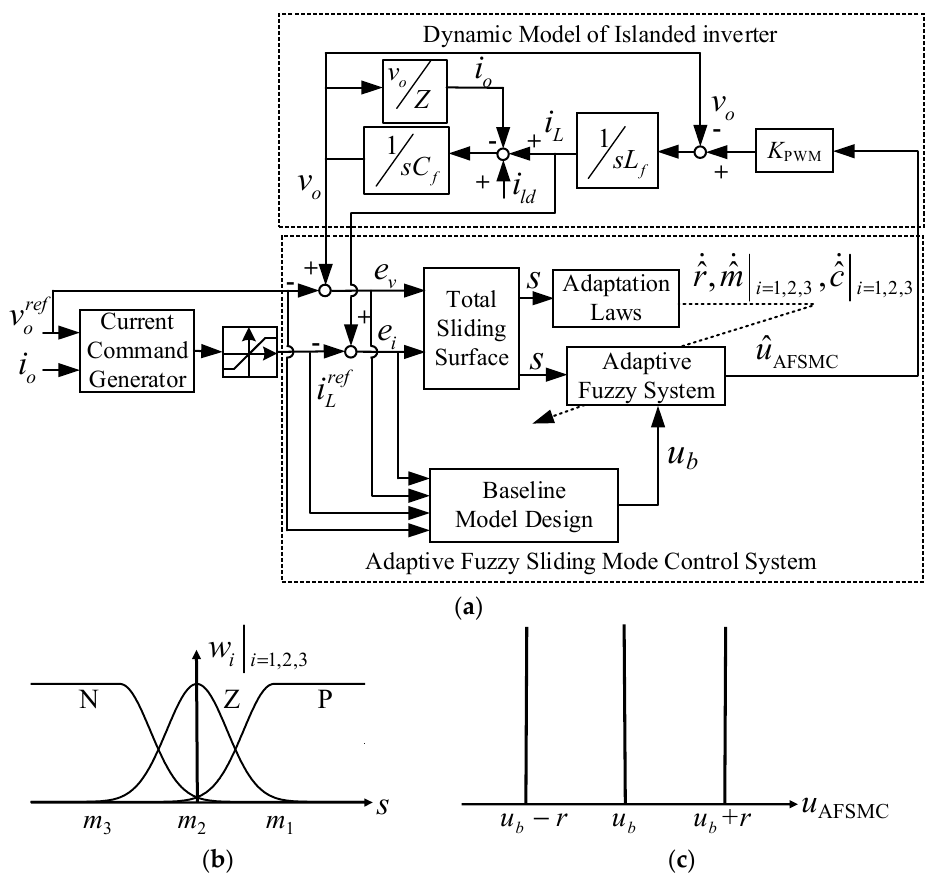
Figure 3. Proposed AFSMC system for islanded inverter: ( a ) Framework; ( b ) Membership function for input fuzzy sets of the fuzzy system; ( c ) Output fuzzy sets of the fuzzy system.